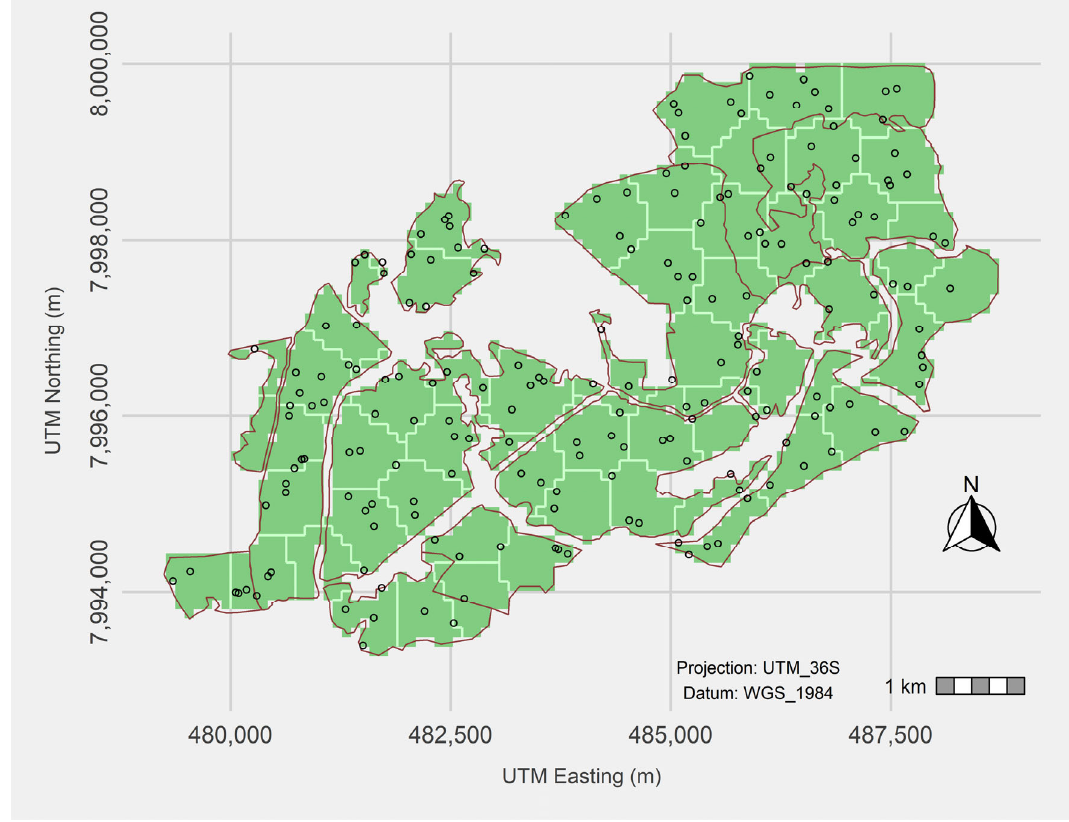
Figure 2. Study area sampling design.